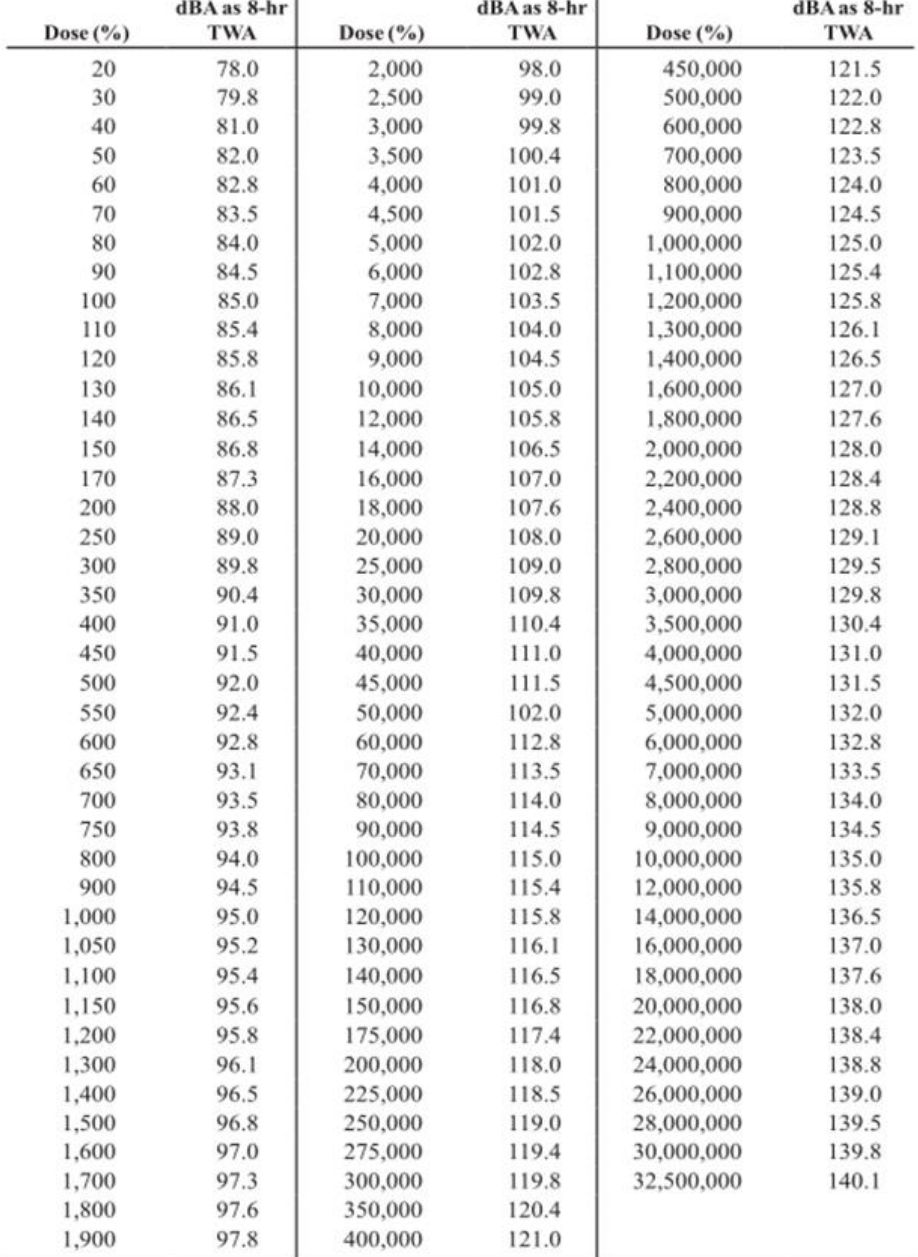
Figure 2. Daily noise dose as an 8 h TWA .